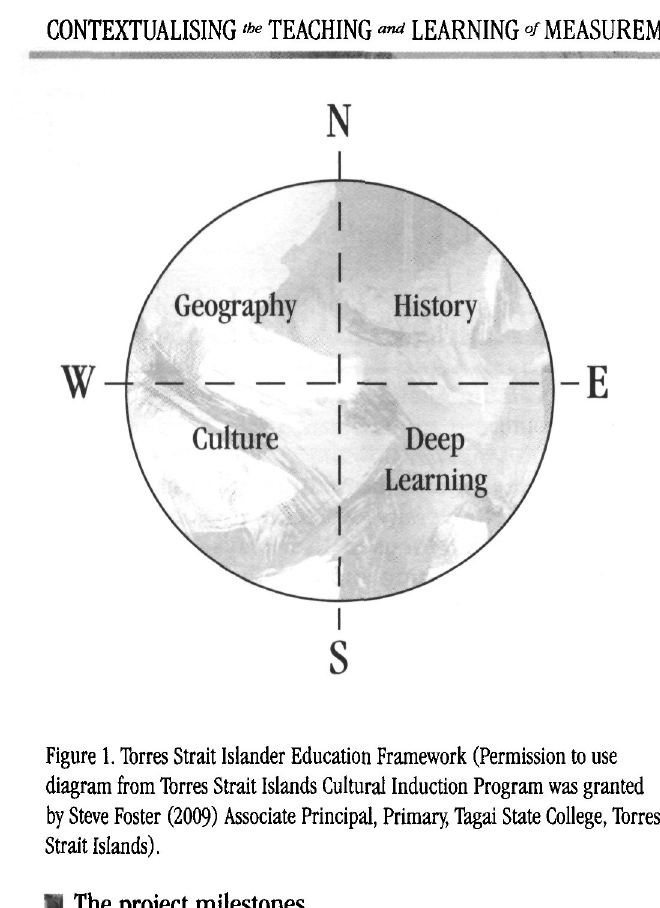
Figure 1. Torres Strait Islander Education Framework (Permission to use diagram from Torres Strait Islands Cultural Induction Program was granted by Steve Foster (2009) Associate Principal, Primary, Tagai State College, Torres Strait